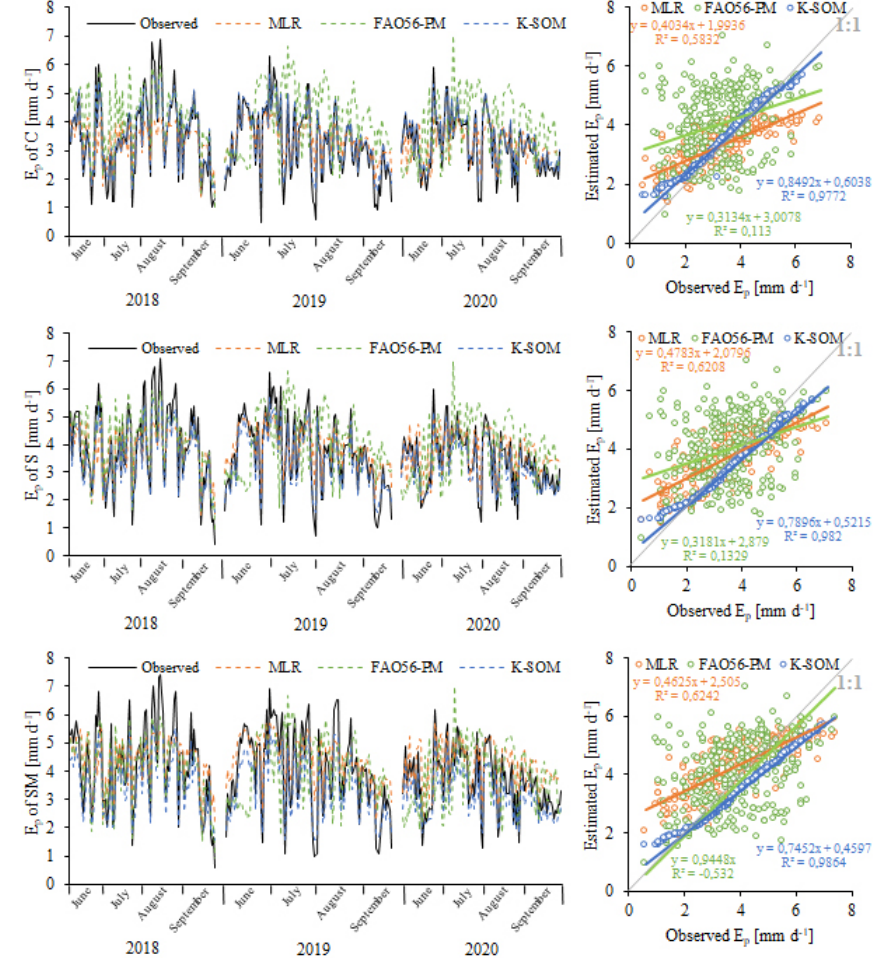
Figure 7. Time series and X – Y scatter plot of observed and predicted daily pan evaporation ( E p ) in different pan treatment (C – control, S – pan with sediment cover bottom, SM – pan with submerged macrophytes) by daily multiple stepwise regression (MLR), FAO-56 Penman– Monteith (FAO56–PM), and Kohonen self-organisation map (K–SOM) models during testing period (2018–2020 growing seasons). All probability levels were equal to p < 0 .